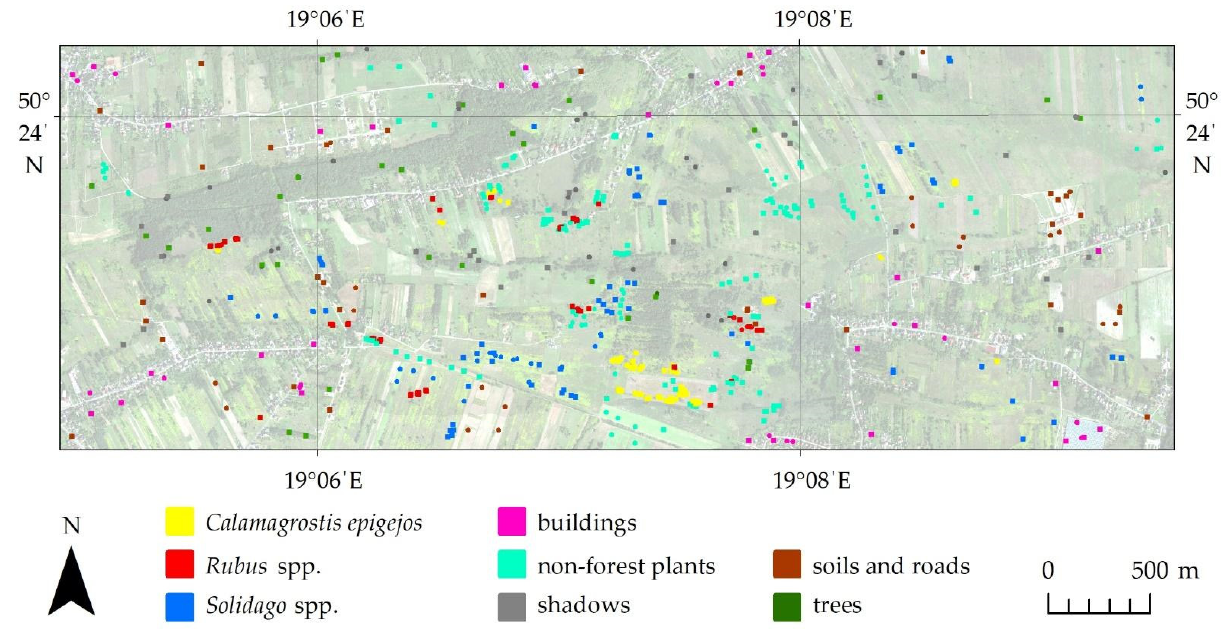
Figure 3. Location of reference polygons in the research area.